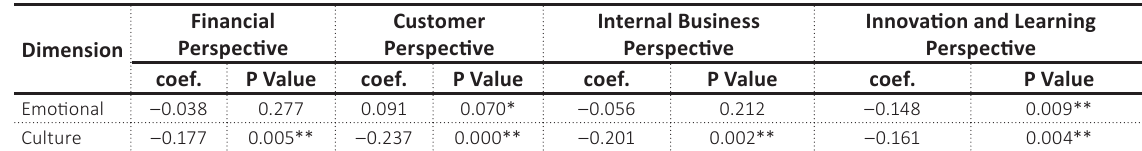
Table 6. Expansion test of the emotional and cultural dimensions’ effect on corporate performance